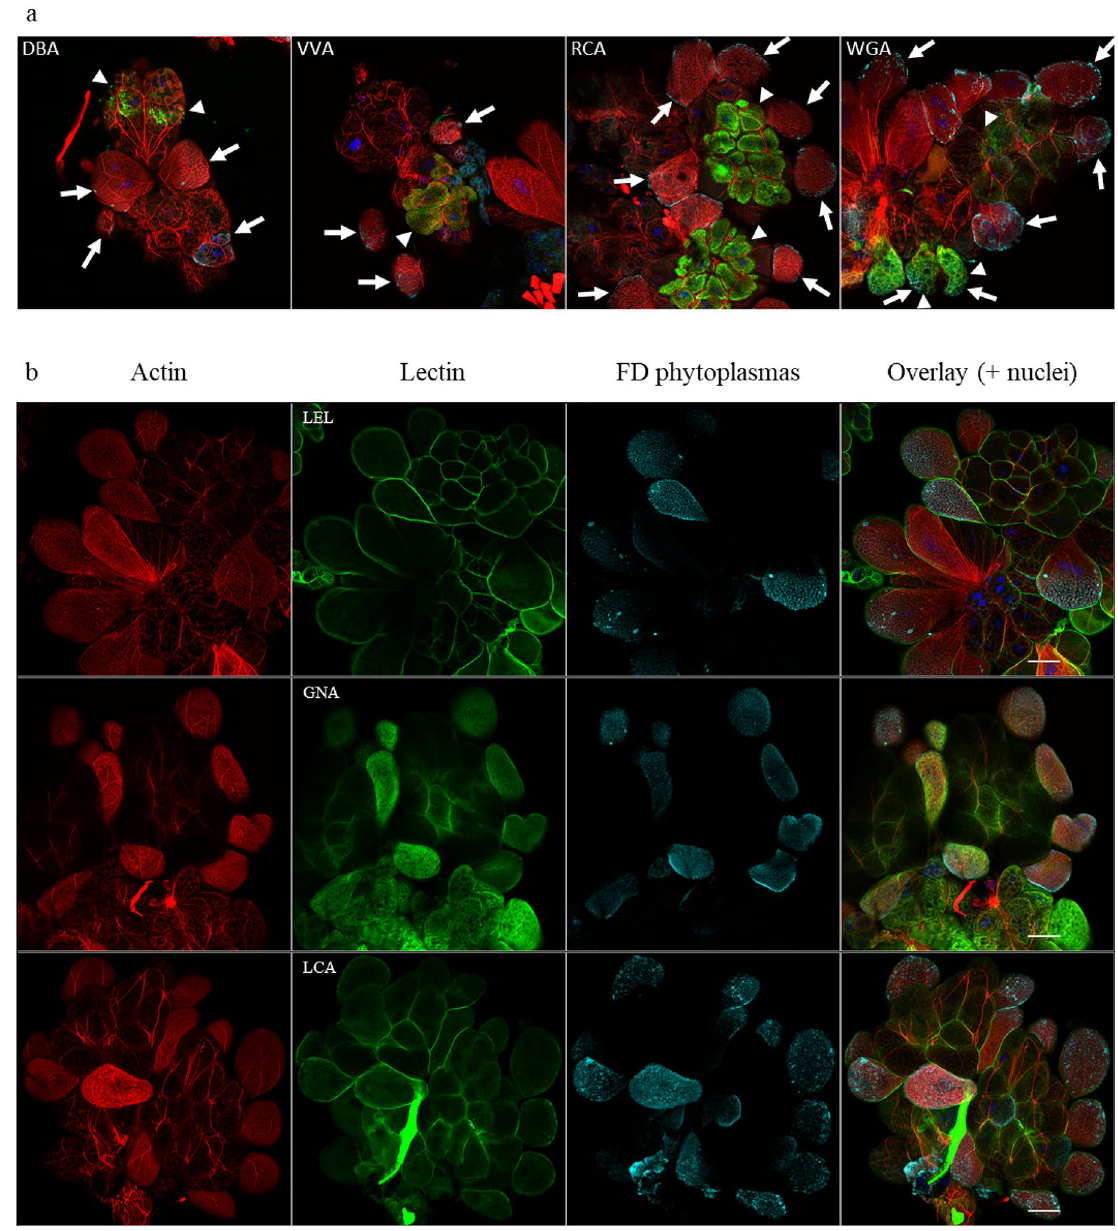
Figure 3. Observation by laser scanning microscopy of fluorescent lectins binding salivary gland carbohydrates of FDP-infected E . variegatu s. Cell nuclei were stained with DAPI (blue), actin filaments with Alexa 568-phalloidin (red), phytoplasmas with anti-VmpA antibodies and Alexa 633-secondary antibodies (cyan), and FITC-lectins are colored green. ( a ) Overlay pictures of infected salivary gland cells stained with the lectin indicated in each picture. Arrows indicate the FDP-infected cells, and arrowheads indicate the cells recognized by the lectin used. ( b ) View of the infected salivary gland surfaces stained with the lectin indicated in each picture. Scale bar 100